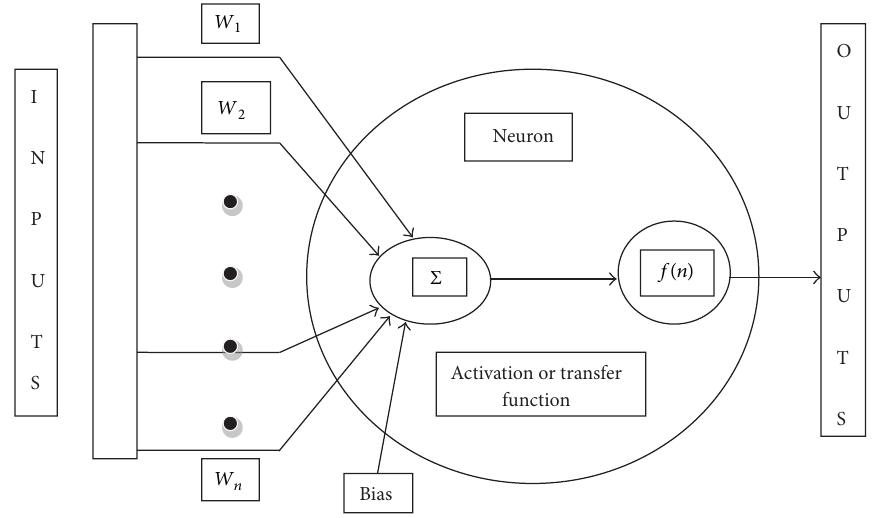
Figure 5: Model of an Artificial